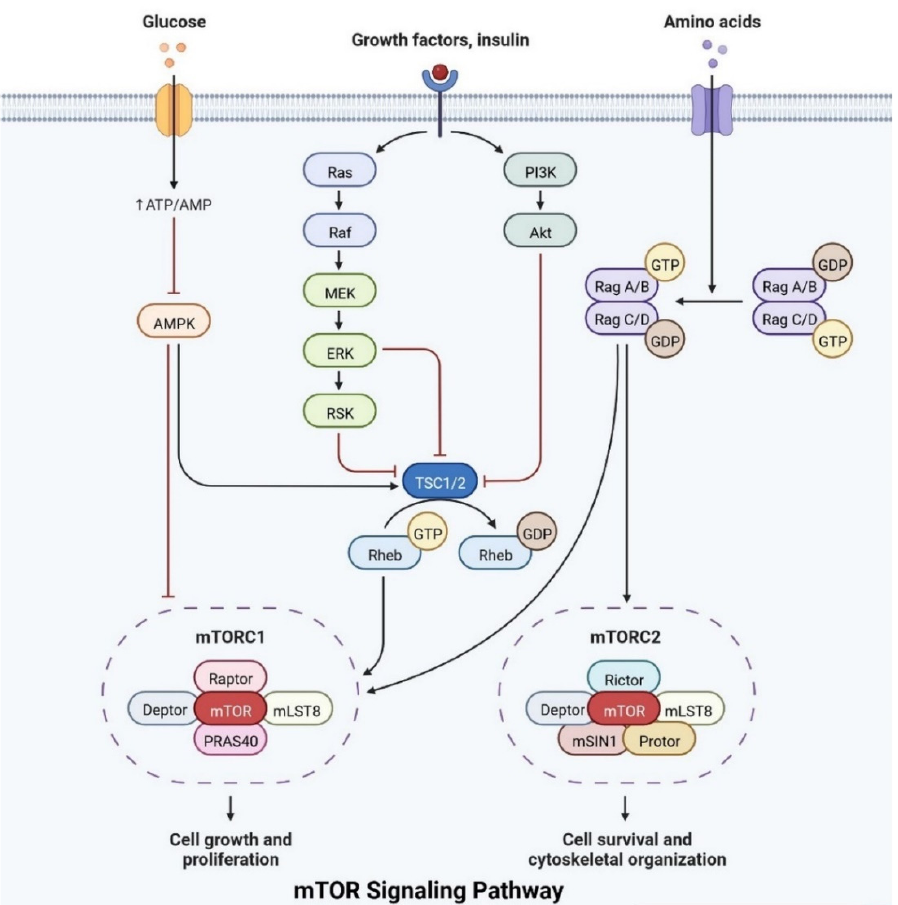
Figure 8. The mTOR pathway integrates growth factor signaling to regulate cellular metabolism, growth, and survival.